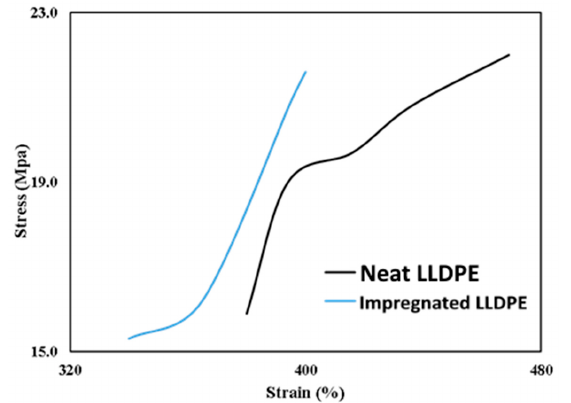
Figure 11. Stress-strain curves of neat LLDPE and LLDPE impregnated with rosemary essential oil.